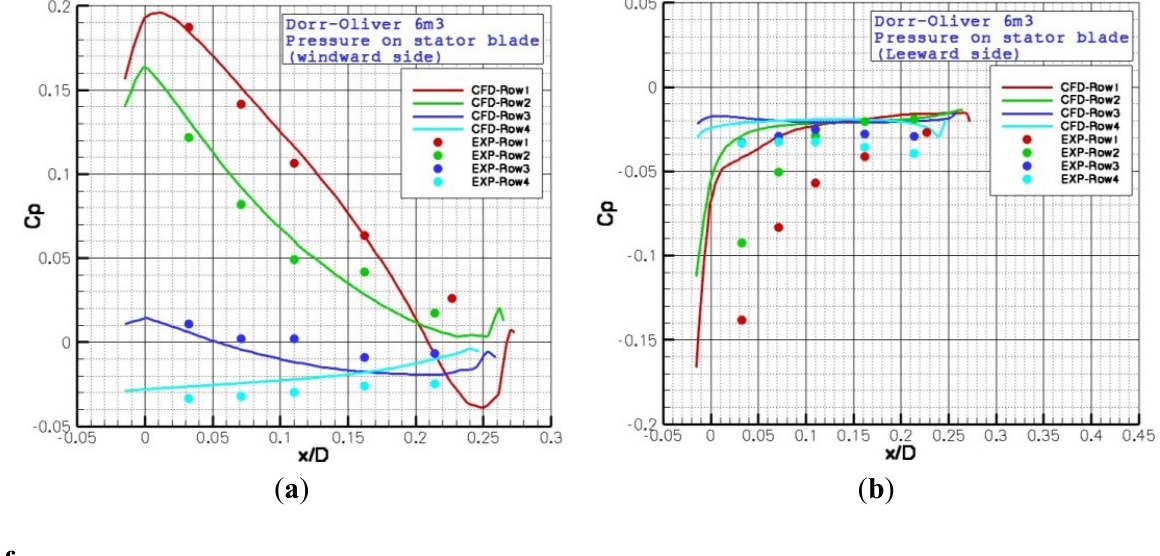
Figure A4. ( a ) Comparison of CFD and experiments pressure distribution on stator blade: windward side. And ( b ) comparison of CFD and experiments pressure distribution on stator blade: leeward